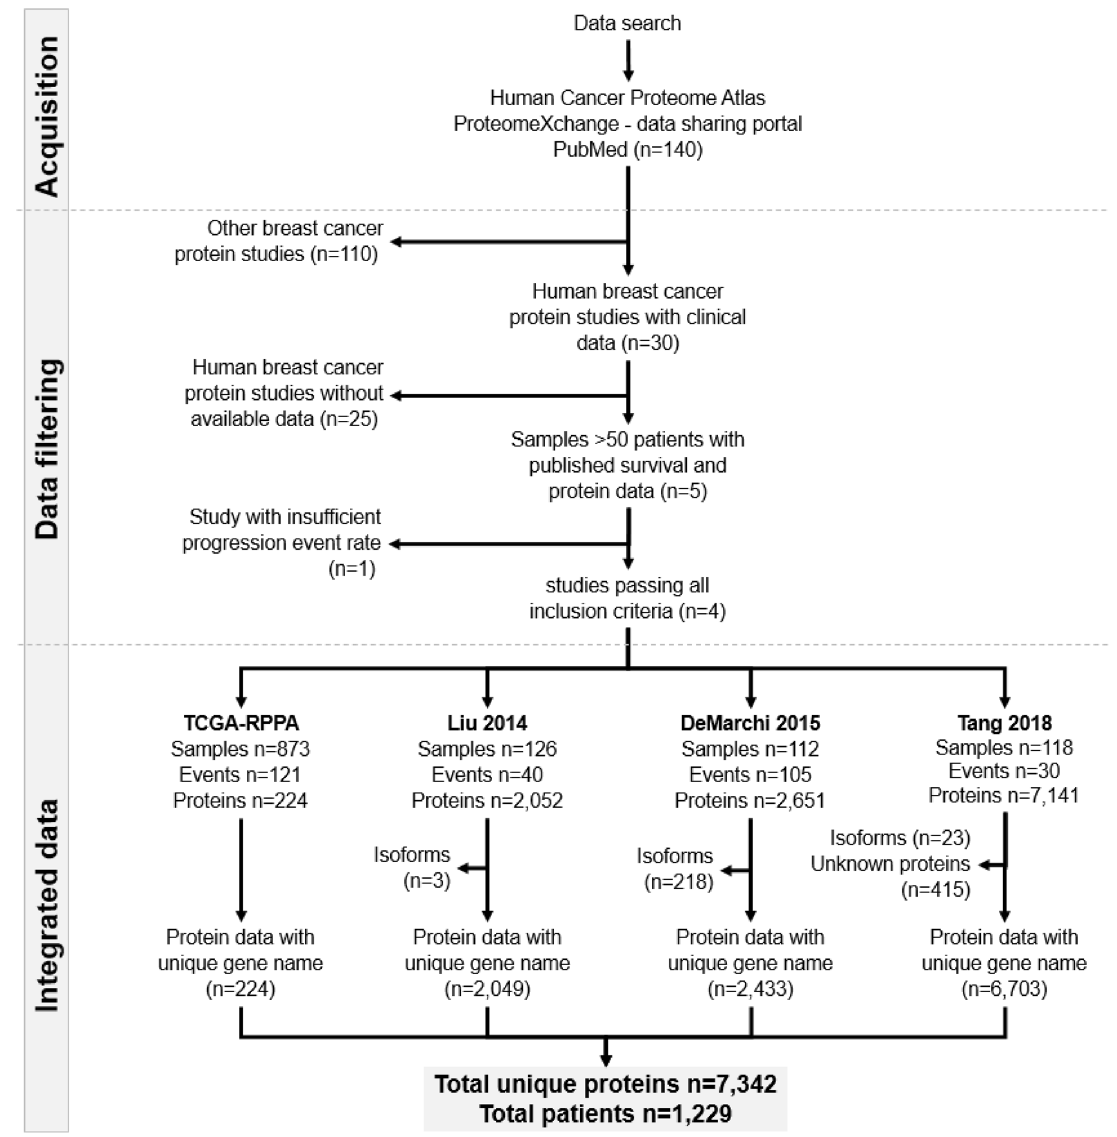
Figure 1. Data acquisition workflow, the number of samples and unique proteins in each included